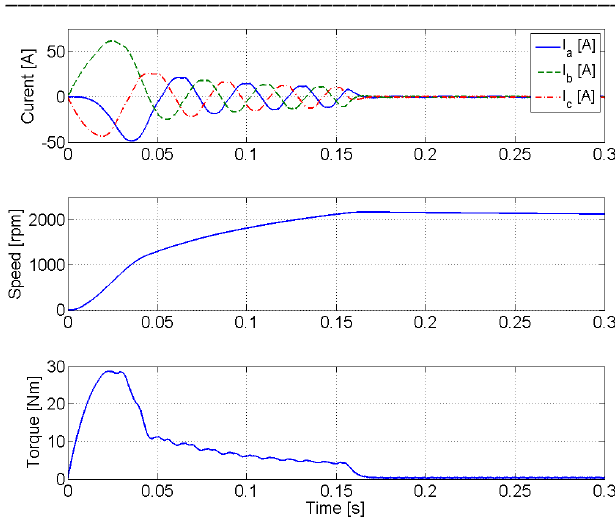
Fig. 11. Phase current, speed and torque of the motor during a controlled start- up in the Simulink model.